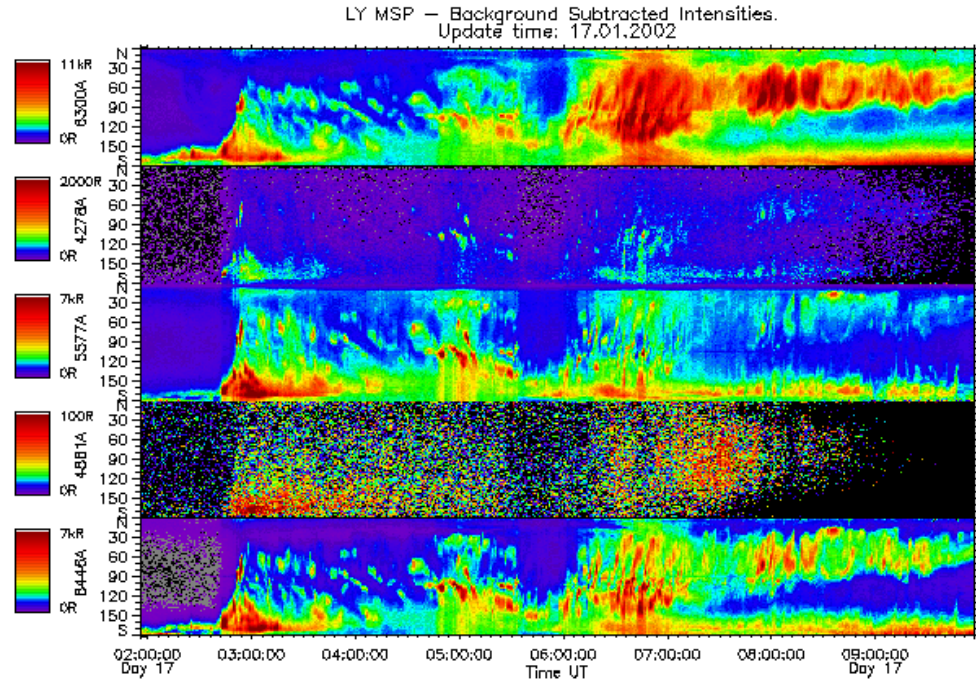
Fig. 7. Meridian scanning photometer data from 02:00–10:00 UT, 17 January 2002. The panels show the 630 . 0nm, 427 . 8nm, 557 . 7nm, 488 . 1nm and 844 . 6nm auroral emissions from top to bottom, respectively. In the absence of other optical observations, the 630 . 0nm panel gives the impression of a stable red arc which has been associated with enhanced ion-acoustic echoes in earlier studies.